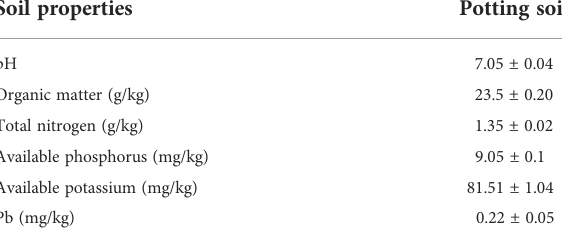
TABLE 1 Physical and chemical properties of potting